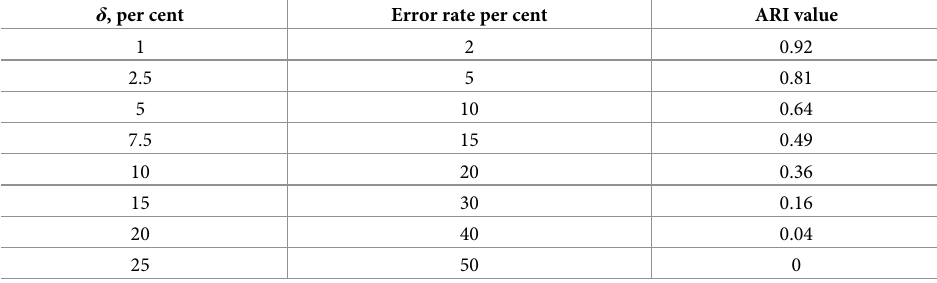
Table 7. A calibration table relating the error rate in the model confusion example with the corresponding ARI values. δ , per cent